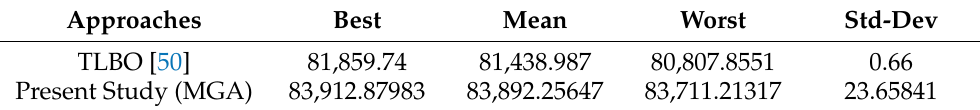
Table 22. Statistical results of different approaches for the rolling element bearing design